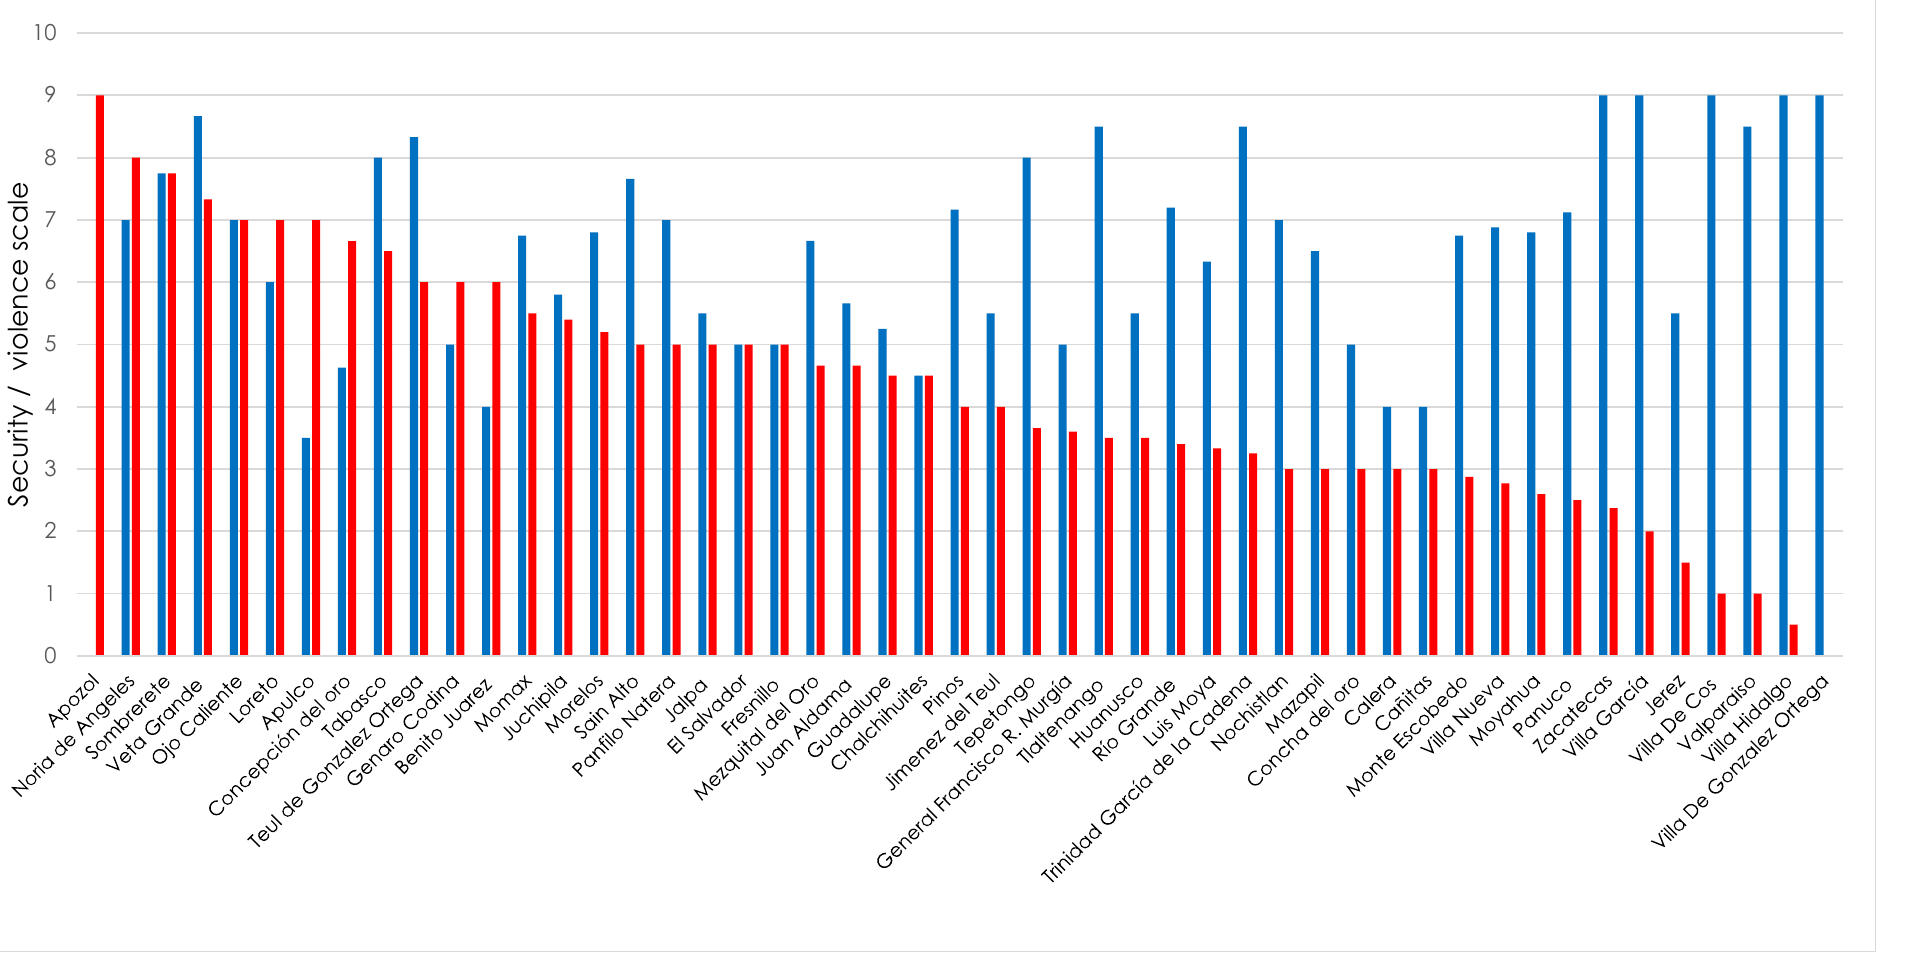
Figure 4. Levels of security and violence perceived by SSMIs in the state of Zacatecas in the 2020–2021 class on the medical units where they did their social service work. Plot was constructed without distinguishing by sex the study population. Security level: blue bars. Violence level: red bars.